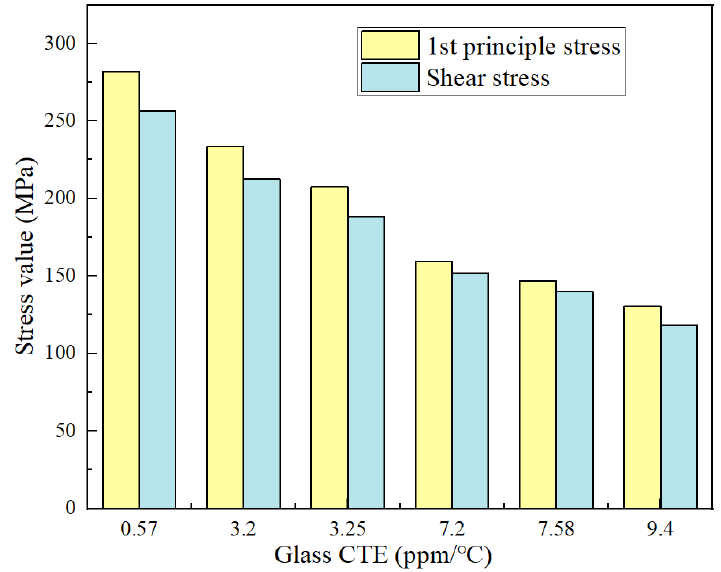
Figure 12. Effect of glass CTE on stress.